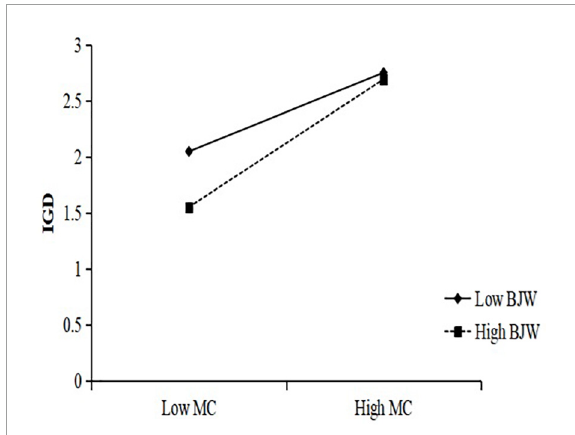
FIGURE2 The moderating effect of belief in a just world on perception of school climate to internet gaming disorder.